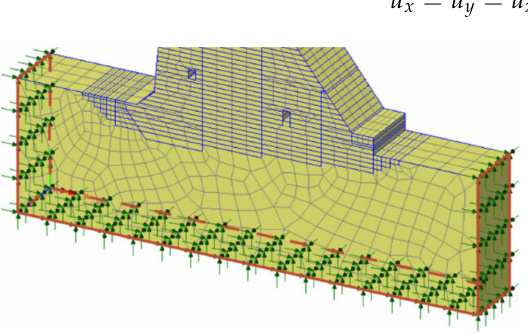
Figure 6. The boundary condition for conducting stress